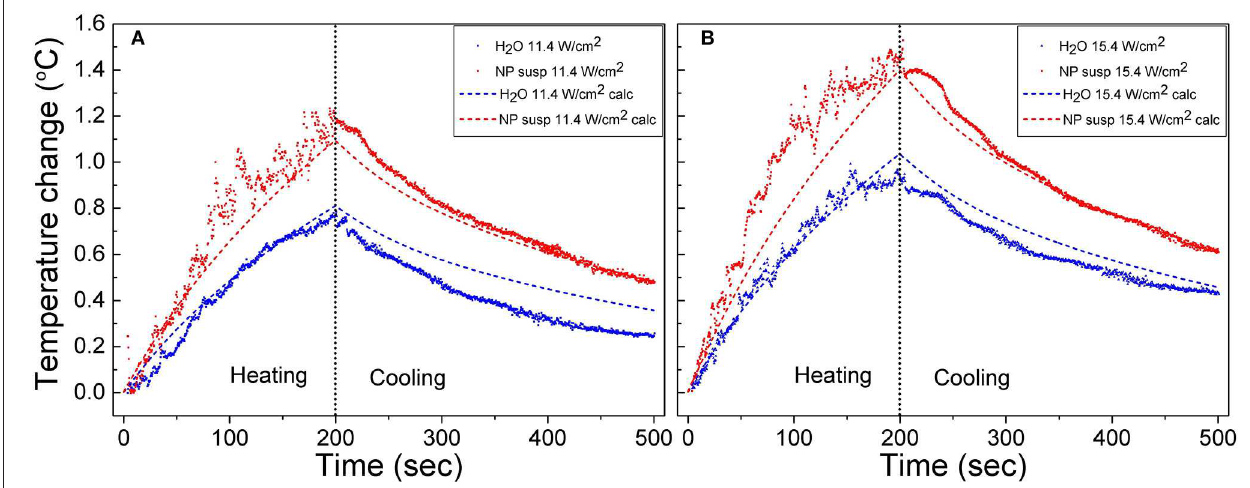
FIGURE 4 | Raw heating and cooling curves for the suspension of J-PSi NPs and water obtained in the experiment under exposure to US with the intensities of 11.4 (A) and 15.4 W/cm 2 (B) (shown by color points). Dashed curves correspond to the numerical